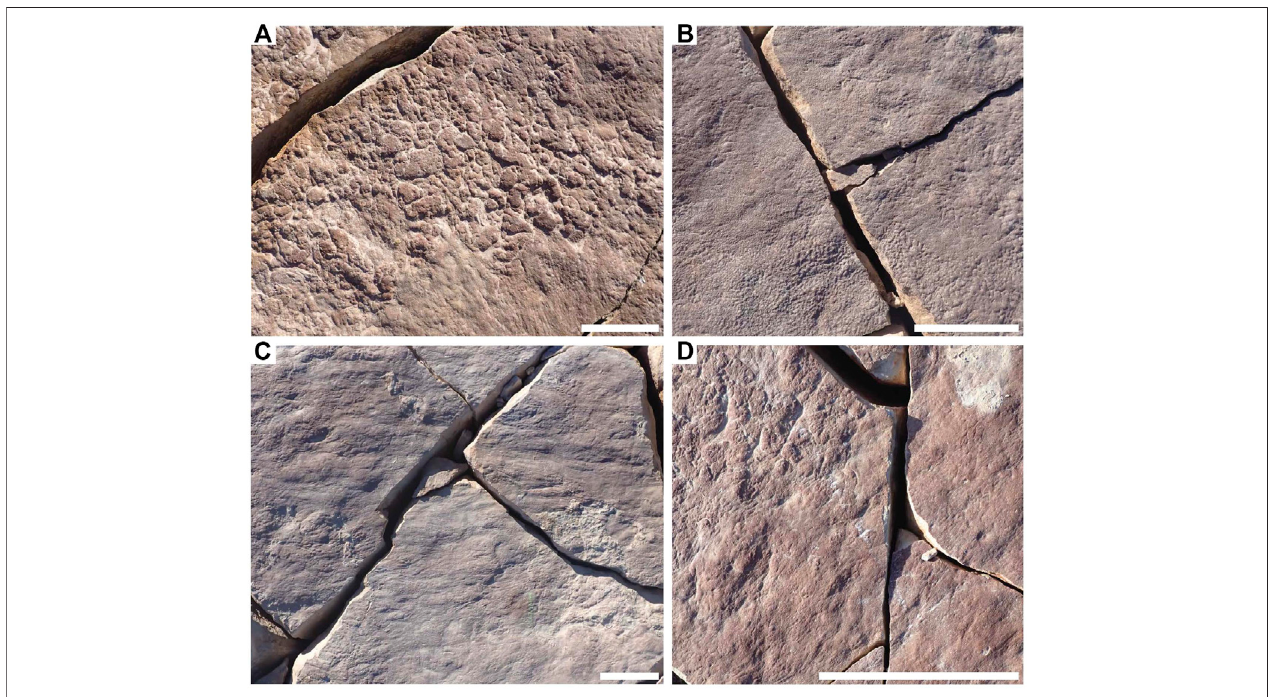
FIGURE 2 | Distinct mat textures preserved in hyporelief on bedding plane LV-Fun. (A) Clotted TOS. (B) Foam TOS. (C) Hair TOS. (D) Hair and clotted TOS in distinct patches with sharp transitional boundaries. Scale bars = 5 cm.